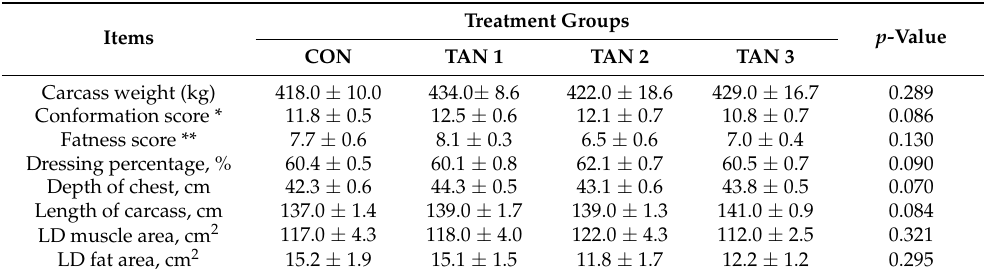
Table 4. Effect of supplemented hydrolyzable tannins on carcass quality of Limousin bulls during a 213-day trial.